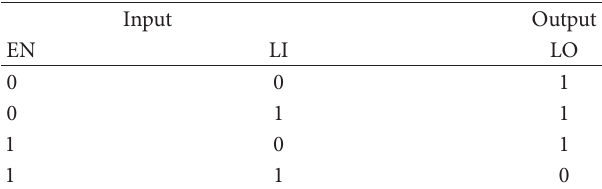
Table 1: Logic table of